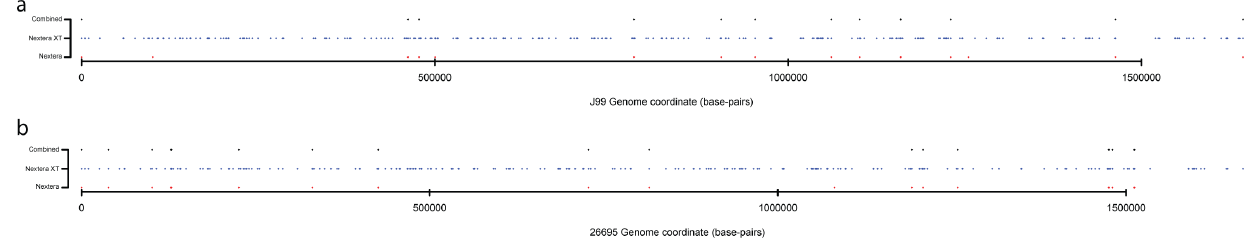
Figure 4. Regions with inadequate sequence depth. Regions in J99 (a) and 26695 (b) where the depth is less than or equal to 3 nucleotides of coverage for Nextera (red), Nextera XT (blue), with black representing common non-covered bases.